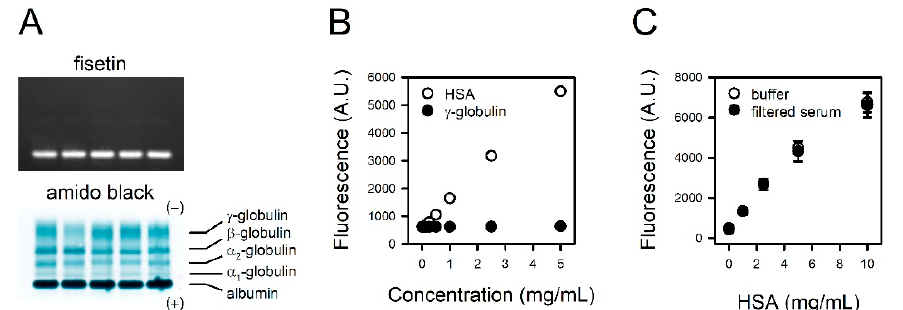
Figure 3. Specificity of fisetin to HSA. ( A ) The proteins in human sera from five donors were separated on agarose gel. The gels were stained with fisetin (upper panel) or amido black (lower panel). ( B ) The HSA or γ -globulin solutions were reacted with fisetin, and the fluorescence was measured. ( C ) The serum was filtered with 3 kDa cut-off filter. Titration curves were obtained with fisetin and HSA solubilized in BBS or serum filtrate. The values are presented as means ± standard errors ( n = 3).